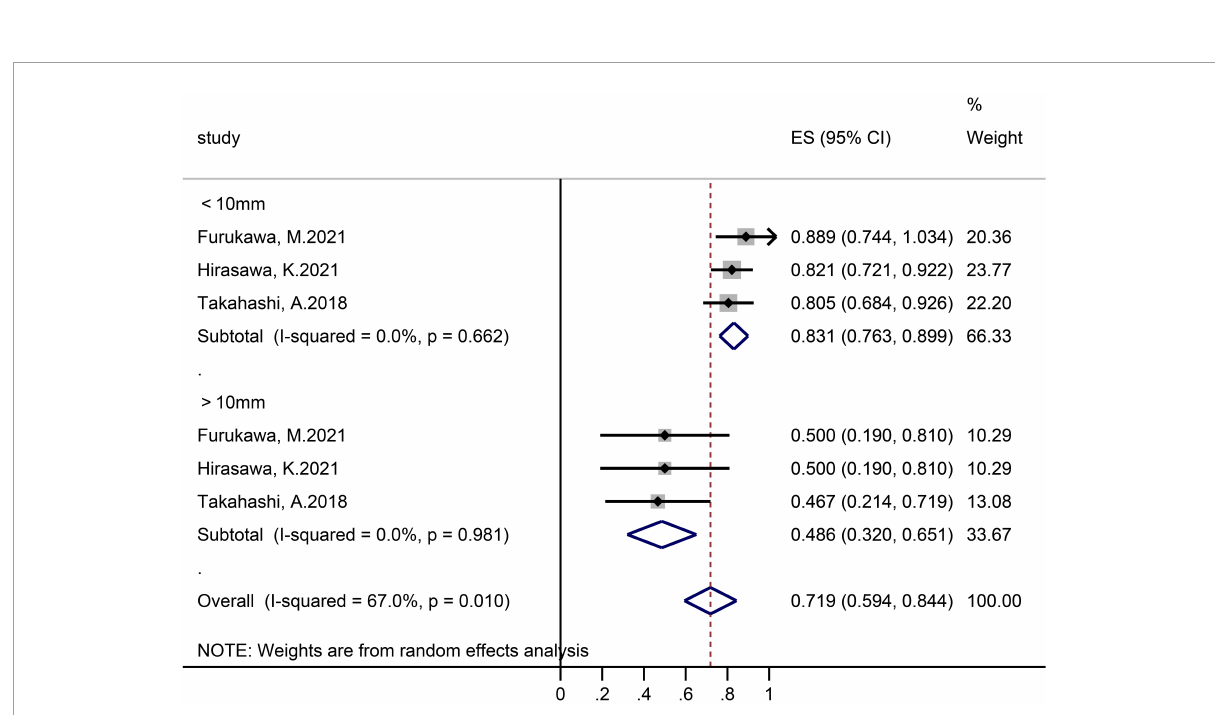
FIGURE5 Forest plot, R0 resection rate, subgroup analysis according to tumor